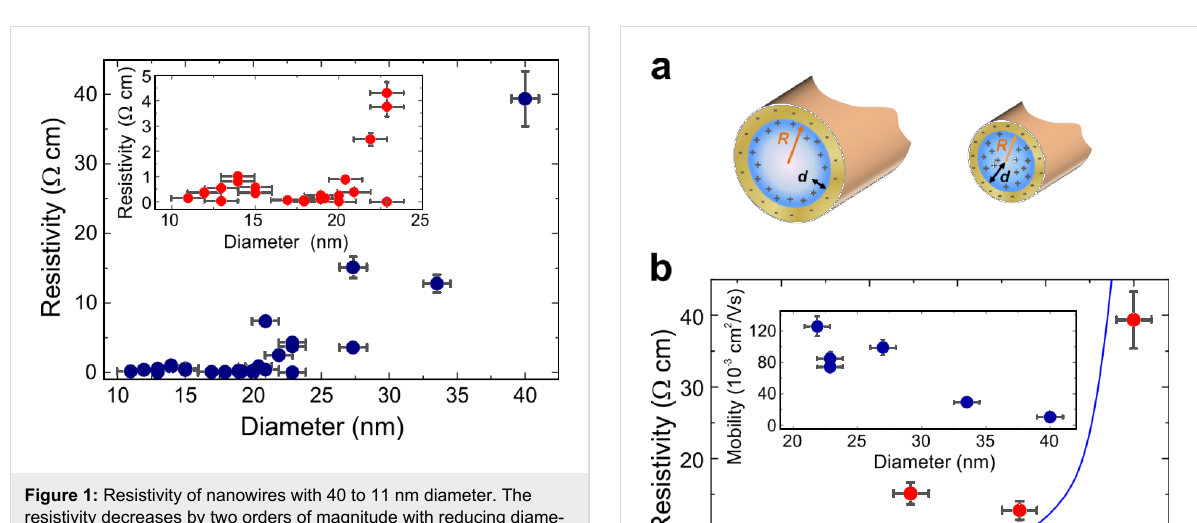
Upon NW diameter reduction, first the resistivity revealed a rapid drop by two orders of magnitude, followed by a region of weakly varying resistivity below 20 nm diameter. Prior to this region, an increased scattering of the resistivity values was ob- served coinciding with the NW diameter reaching the excitonic Bohr radius ( ≈ 24 nm [10]), indicating the approach to the quan- tum regime. Furthermore, a peak-like feature was found at around 14 nm diameter (inset Figure 1). In comparison, lightly doped semiconducting NWs were reported to exhibit a strong increase of resistivity with decreasing diameter [17].